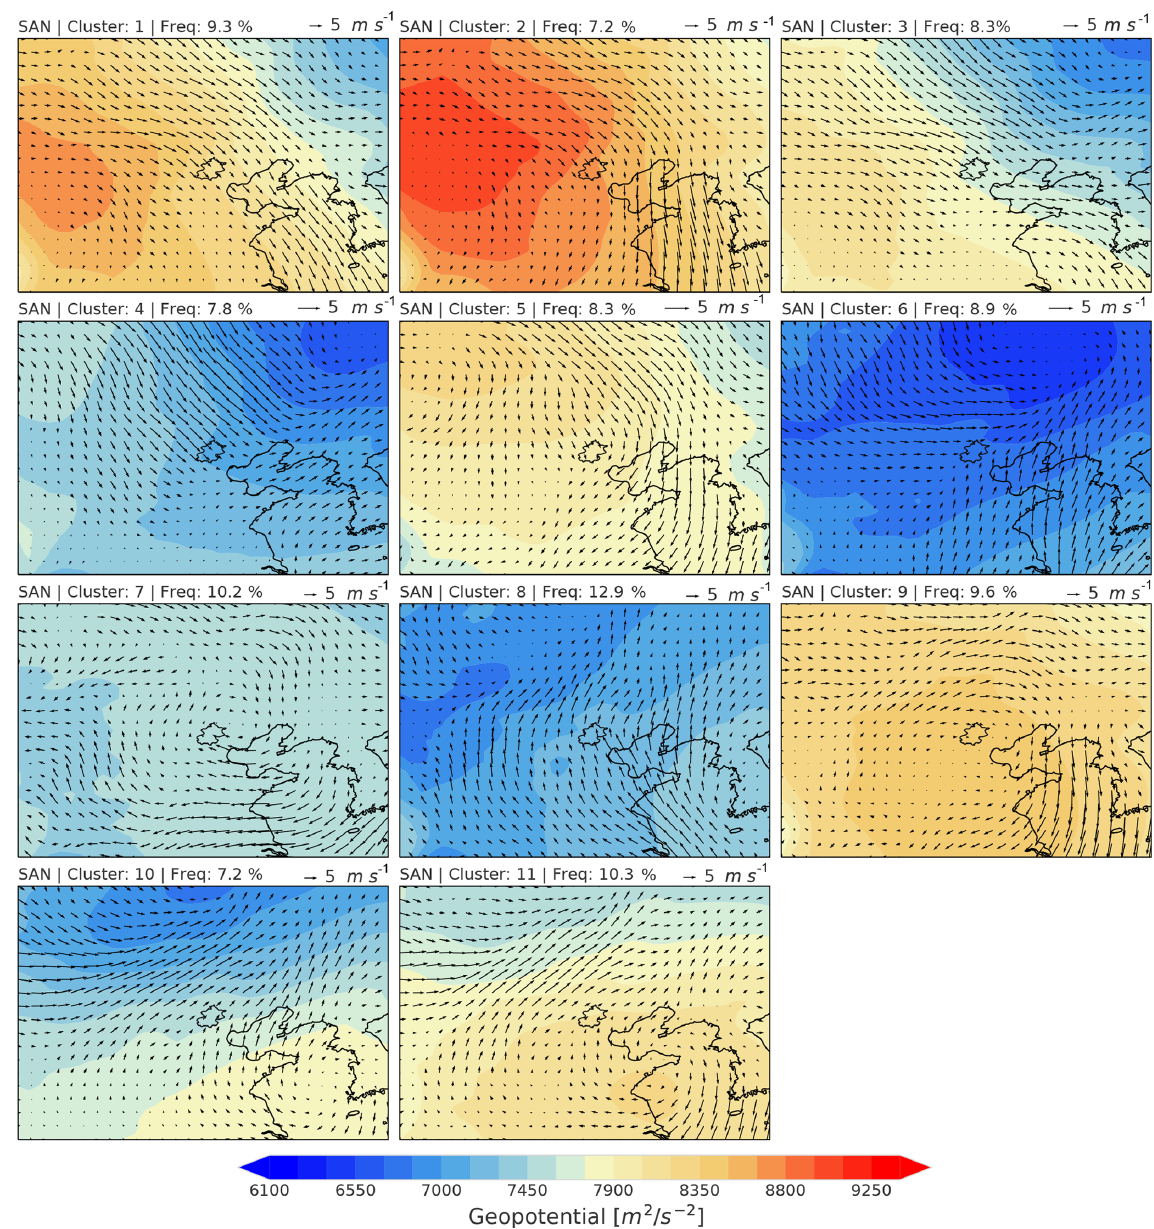
Figure 2. ERA-Interim (1988–2017) average 925hPa geopotential with 10m horizontal wind vector for 11 circulation types classified for Beijing (municipal boundary; thin solid line) surroundings (31–49 ◦ N, 103–129 ◦ E) determined with the SANDRA method (COST733 class software). Frequency of occurrence is given in the cluster caption. For a discussion of conditions associated with each CT, see Sect.